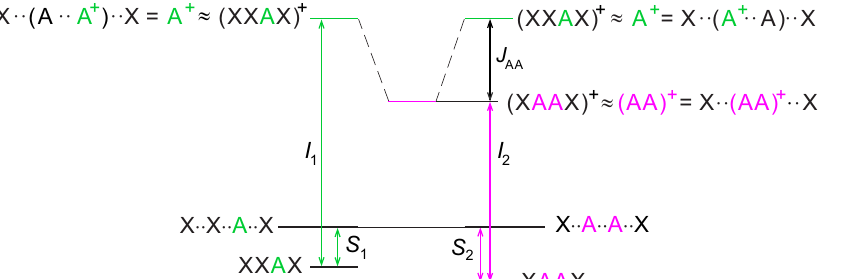
Figure 8. Adenine embedded in the 5 (cid:48) -XXAX-3 (cid:48) and 5 (cid:48) -XAAX-3 (cid:48) tetrameric single strands, where X is a nucleobase with an ionization energy much larger than that of A. Dotted lines denote non-interacting nucleobases, S denote stabilization energies due to stacking interactions in neutral strands and I are ionization potentials. Because the ionization energy of X is much larger than that of A, the effect of coupling terms is negligible in (XXAX) + , so that the hole is fully localized on A. Since A in XXAX and AA in XAAX experience almost identical environments, the difference of the stacking energy in XXAX and XAAX neutral strands is expected to be small ( S 1 − S 2 ≈ 0); therefore, the difference of hole energies of XXAX and XAAX oligonucleotides is well approximated by the difference of ionization energies, J AA ≈ I 1 − I 2 . Reproduced from Ref. [62] with permission from the PCCP Owner Societies. Table 2. Hole site energies ( ε Y , eV, relative to G + ) and electronic coupling parameters for stacked 5 (cid:48) -YZ-3 (cid:48) base pairs ( J YZ , eV). Y and Z denote native DNA nucleobases. All values are taken from Ref. [62]. Y ε Y J YG J YA J YC J YT G 0.00 0.09 0.15 0.23 0.14 0.43 0.15 0.24 0.68 0.23 0.16